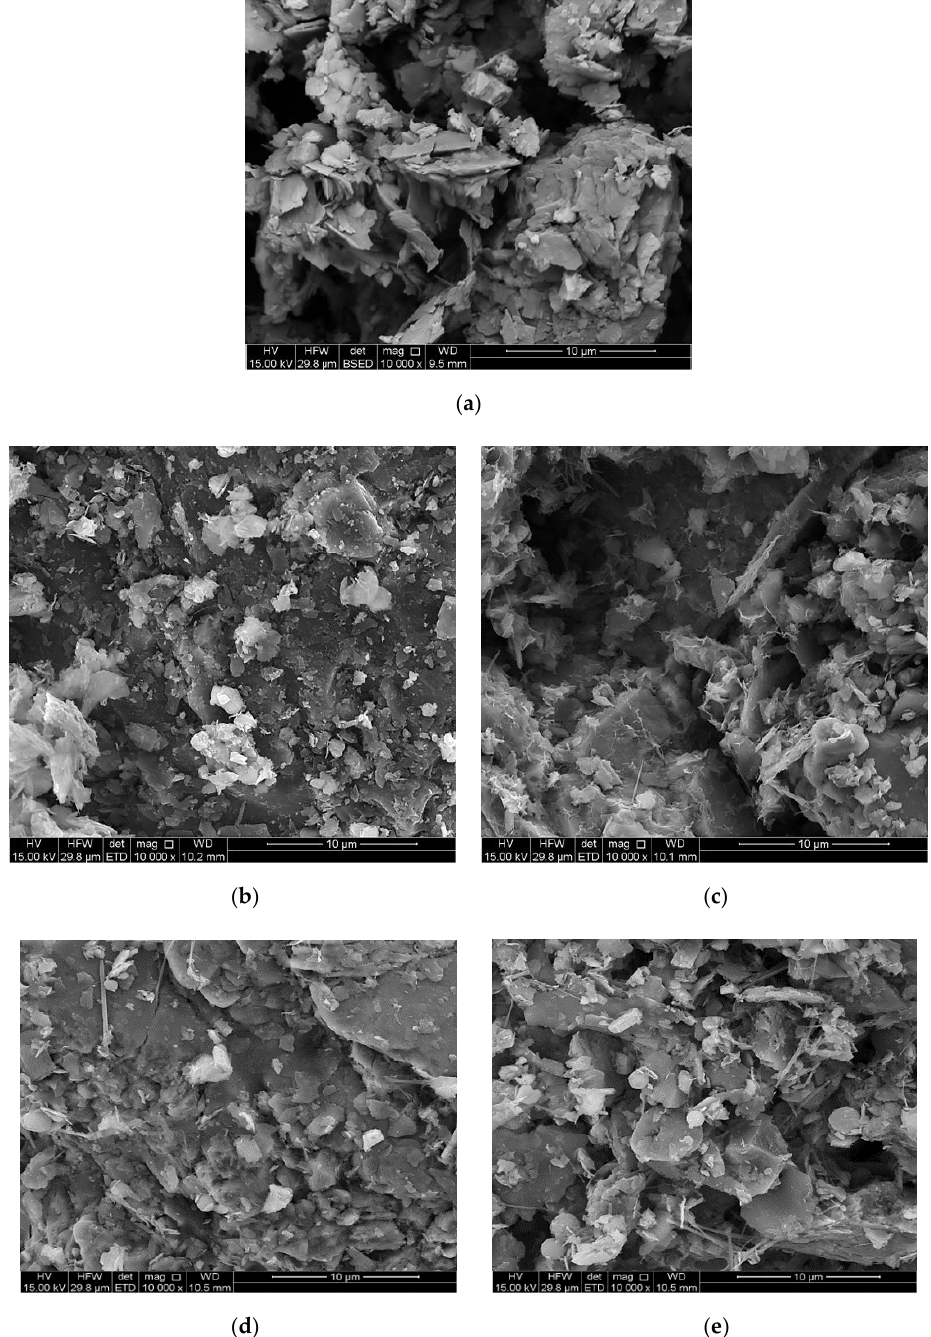
Figure 10. SEM micrographs for the tested samples: ( a ) M 0 F 0 T 7 (pure tailings); ( b ) M 2.5 F 0 T 7 ; ( c ) M 2.5 F 0 T 28 ; ( d ) M 2.5 F 1.5 T 7 ; ( e ) M 2.5 F 1.5 T 28 .